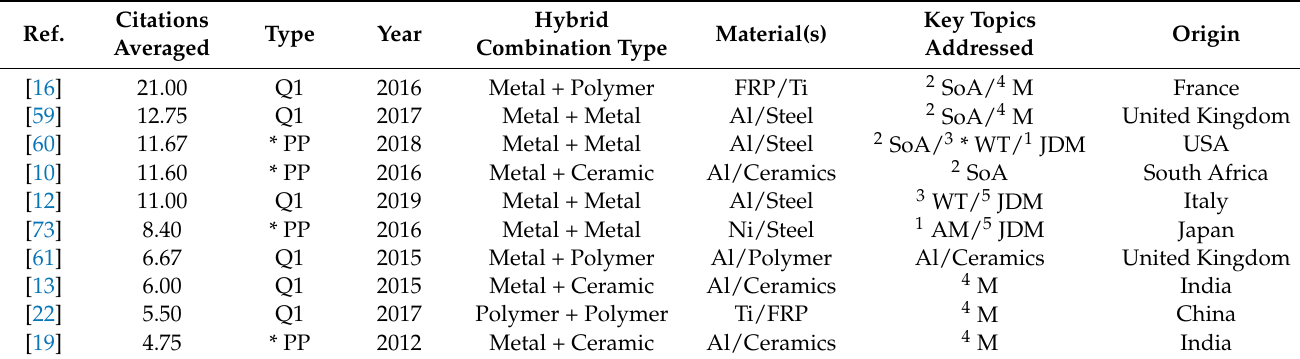
Table 8. Summary of studies including hybrid components, listed by the average number of citations, taking into account the number of years the article has been published.